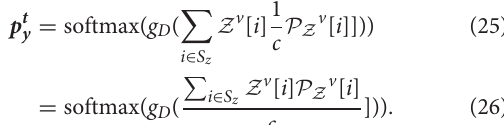
However, this contextualization does not take away that f y mainly corresponds to the token in the image with class y i . In the three- way relation of a confounder, if the two variables X 1 and X 2 that are confounded by variable Z are one and the same ( X 1 = X 2 = X ), we can simply call Z a cause of X . Figure 6 illustrates this. We can thus also speak of “causes” instead of “confounders” when discussing